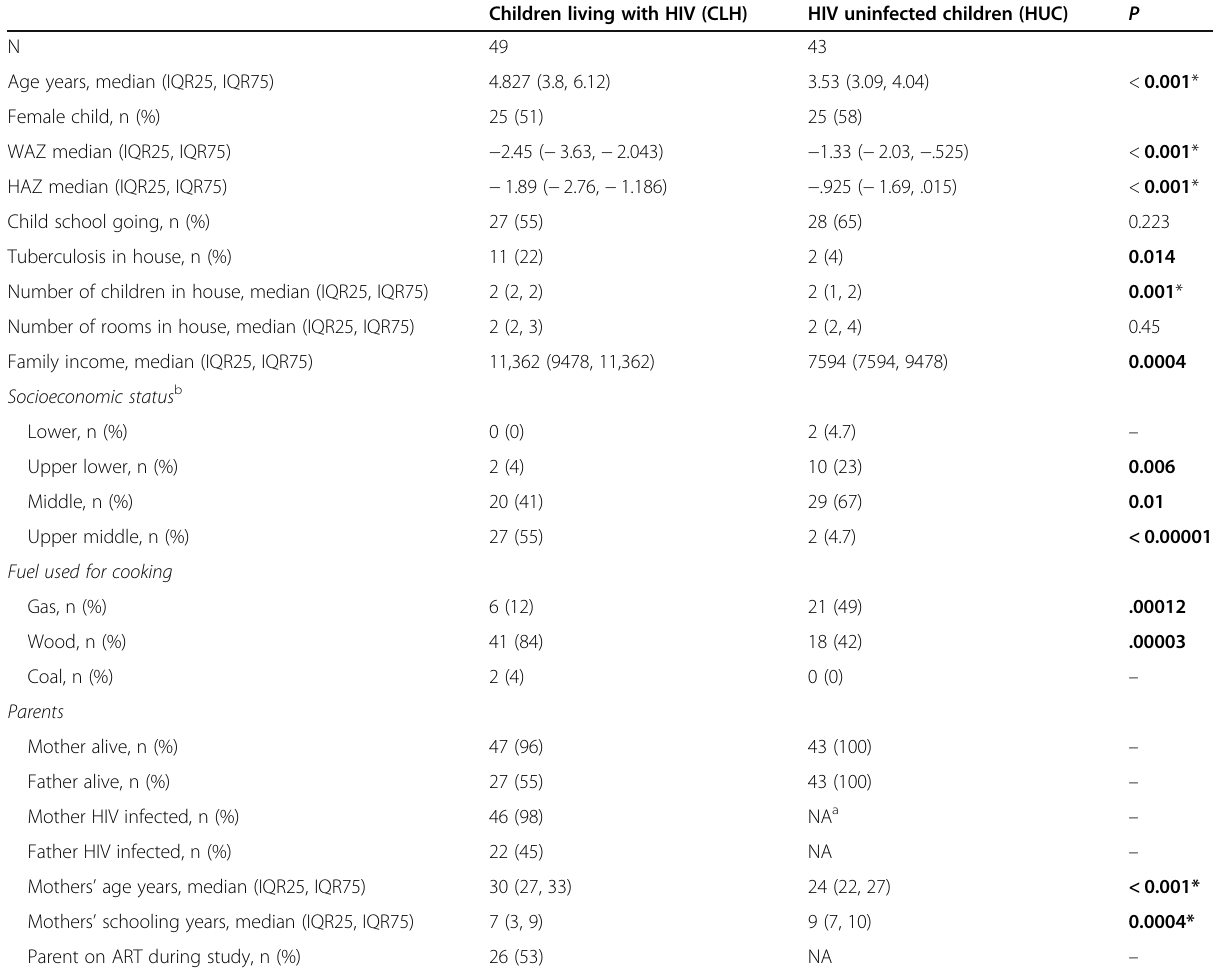
Table 1 Demographic characteristics of children and their parents